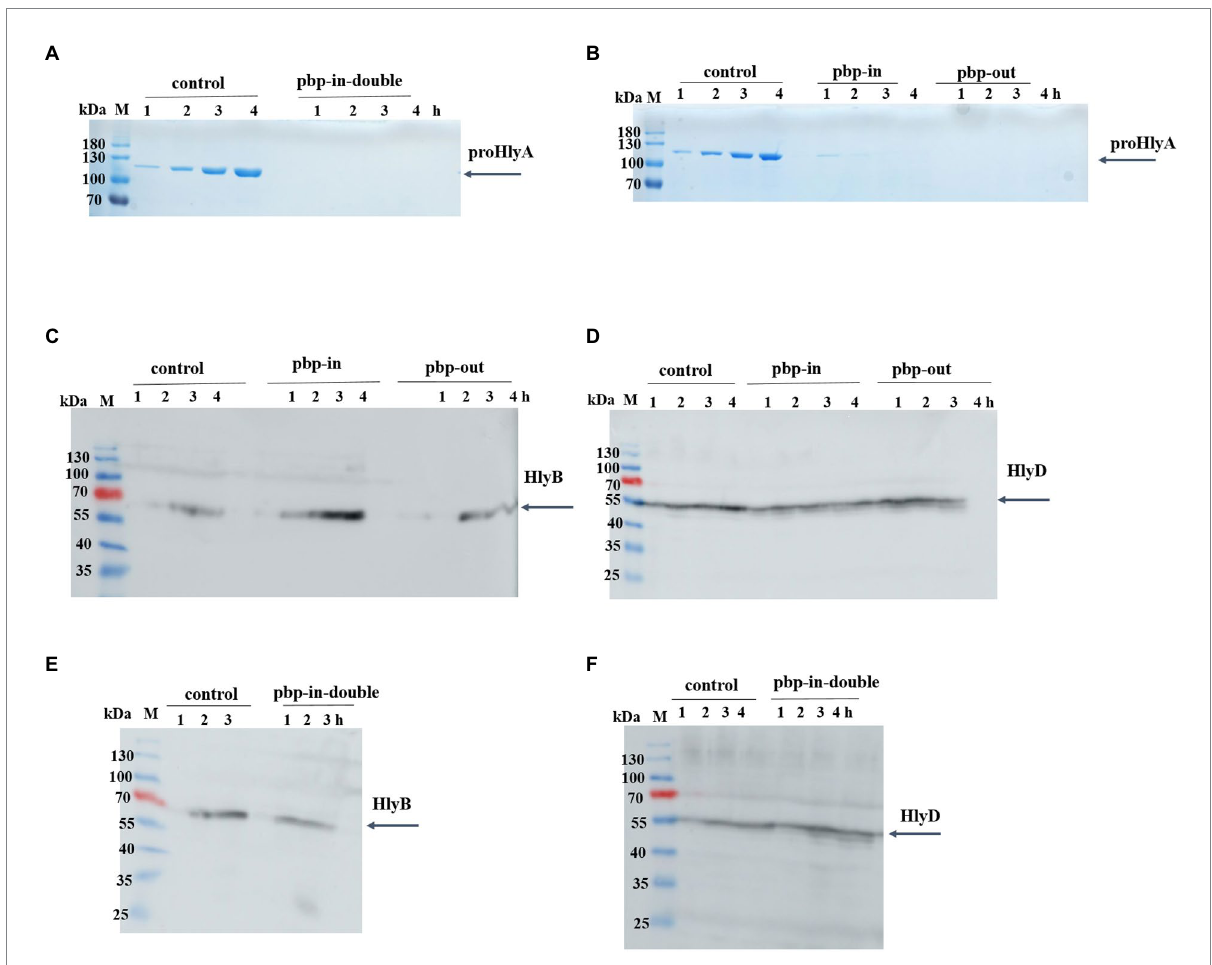
FIGURE 2 Secretion of proHlyA through the HlyA T1SS, in which HlyB harbors mutation. (A) SDS-PAGE analysis of the supernatant (unconcentrated) of clones secreting HlyA, in which HlyB is the wild type (control) or contains double mutations in pbp-in. (B) SDS-PAGE analysis of the supernatant (unconcentrated) of clones secreting HlyA, in which HlyB is the wild type (control), triple mutations in the pbp-in, or triple mutations in the pbp- out. Western blotting of E. coli cells (whole cells) demonstrated that (C,E) HlyB and (D,F) HlyD were expressed for all three mutants at levels comparable to the control cells. M, marker proteins; the molecular weight of the marker proteins is given on the left; xh, unconcentrated supernatant of culture, where x denotes the number of hours after